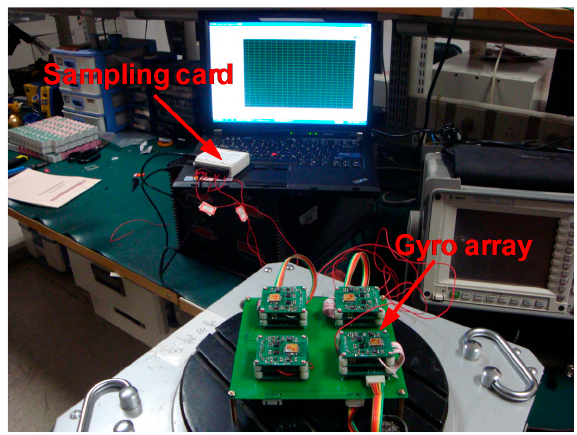
Figure 10. Prototype of the combined system with four-gyro array.